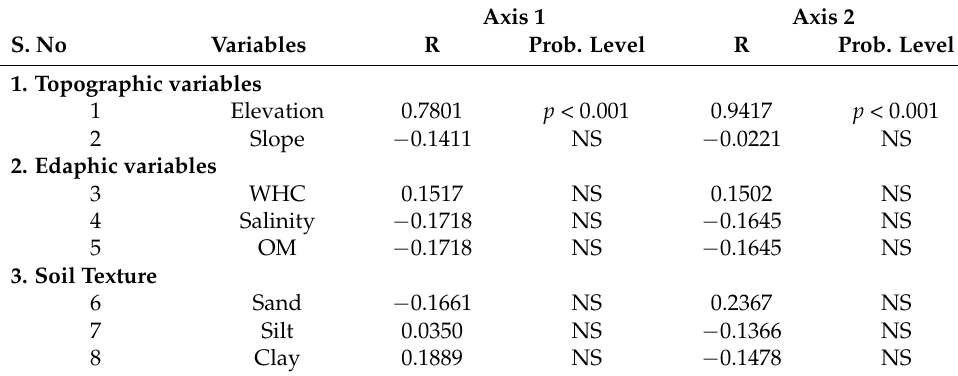
Table 8. Relationship (correlation coefficient) of the environmental variables with two axes of NMS ordination based on understory vegetation.